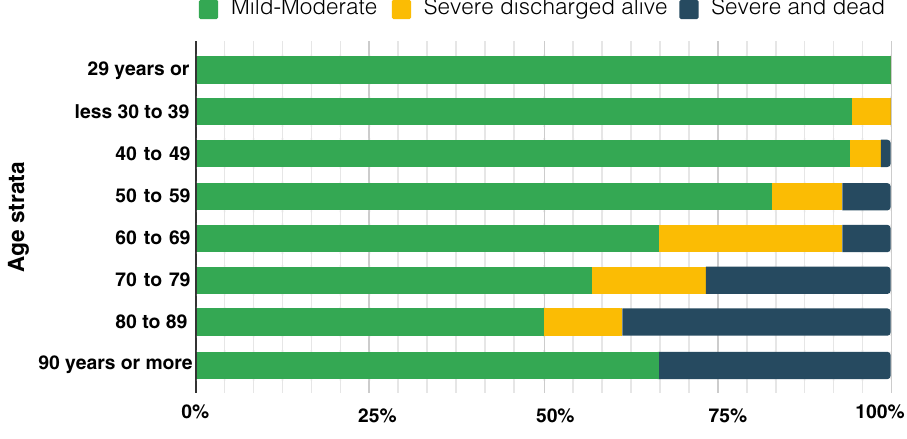
Figure 5. Percentage of severe disease and mortality, by age strata. Total patients in each decade: 29 years or less: 6 patients; 30–39: 35 patients; 40–49: 68 patients; 50–59: 70 patients; 60–69: 84 patients; 70–79: 79